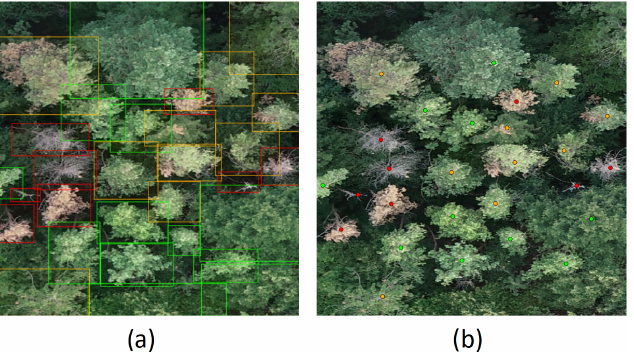
Figure 1. Trees labeled as ( a ) bounding boxes and as ( b ) points on the same orthomosaic with healthy black pines (green), damaged black pines (orange), and dead black pines